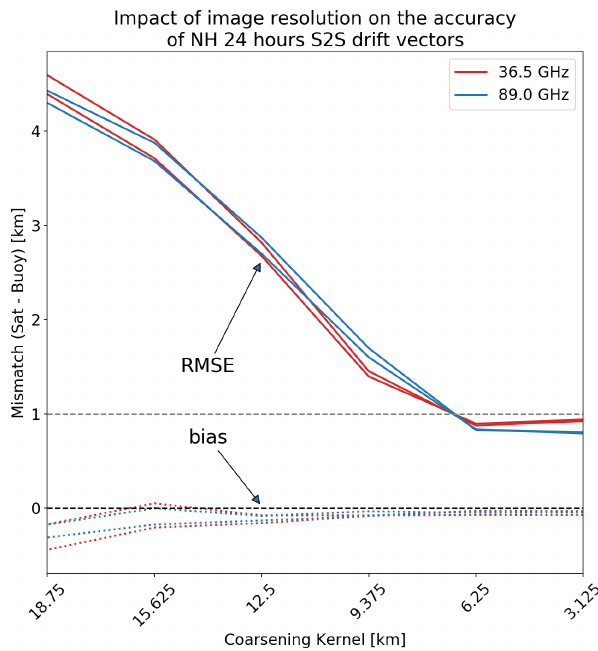
Figure 9. Bias (dashed lines) and RMSE (solid lines) of the NH ∼ 24h S2S drift vectors processed from GCOM-W1 AMSR2 36.5GHz (red) and 89.0GHz (blue) as a function of the width of an image coarsening kernel applied on 3.125km images. The best image resolution is to the right of the x axis. The lines do not dis- tinguish between the d X and d Y components of the drift vectors as they evolve in a similar